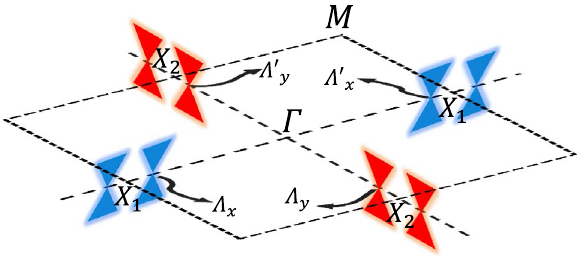
Figure 1. Surface Brillouin zone of pristine SnTe (001) plane. Four Dirac cones at { (cid:31) x and (cid:31) ′ x } near the X 1 point and { (cid:31) y and (cid:31) ′ y } near the X 2 point of SBZ form the surface states in